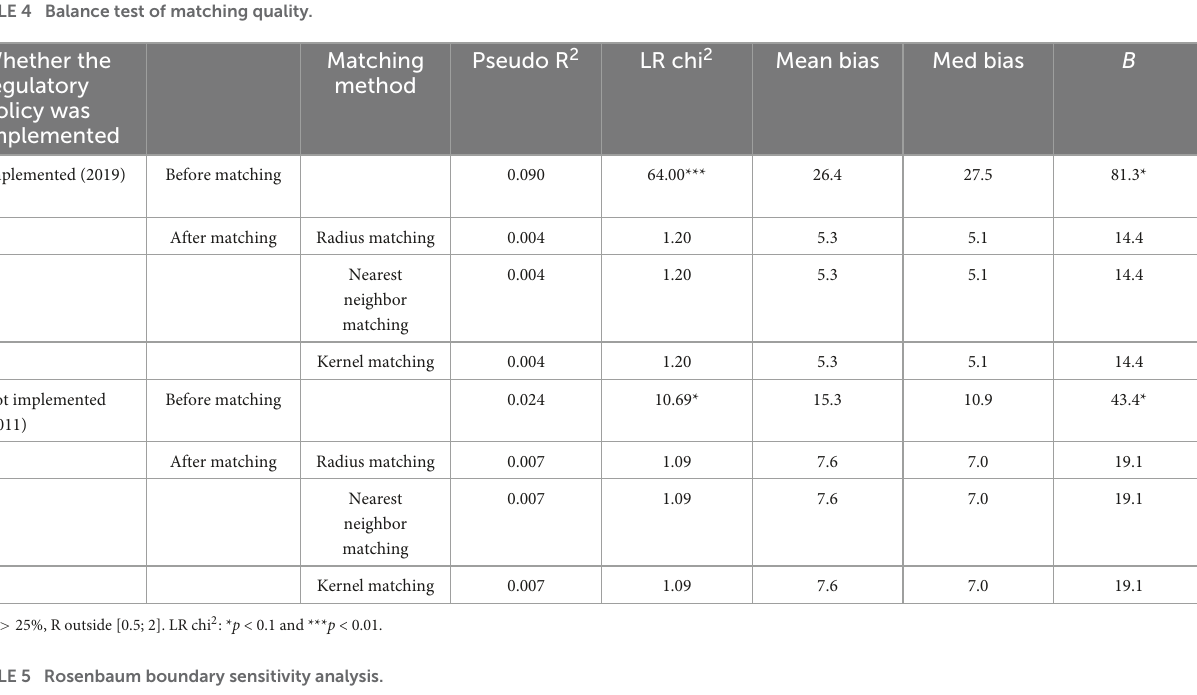
TABLE 5 Rosenbaum boundary sensitivity